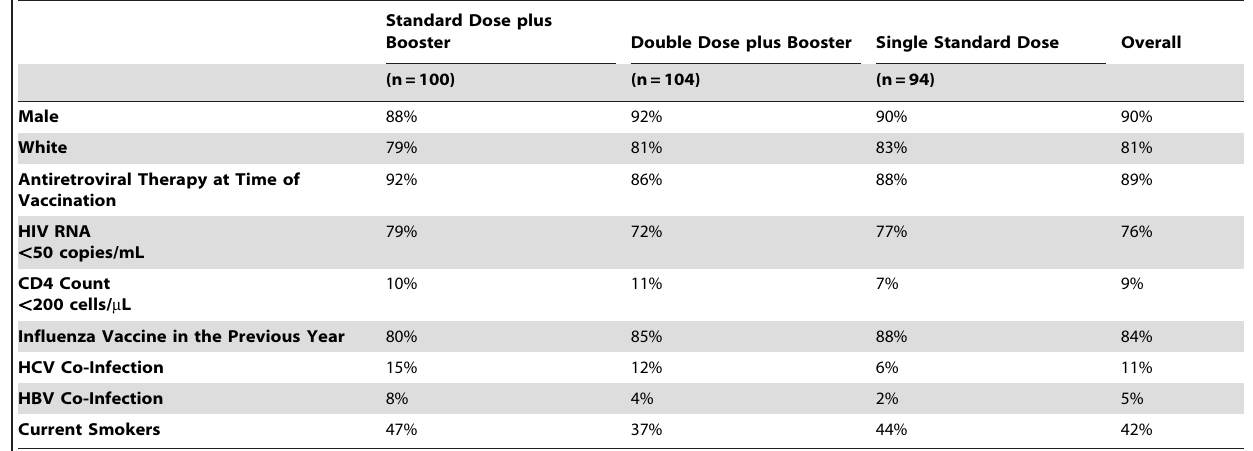
Table 1. Baseline